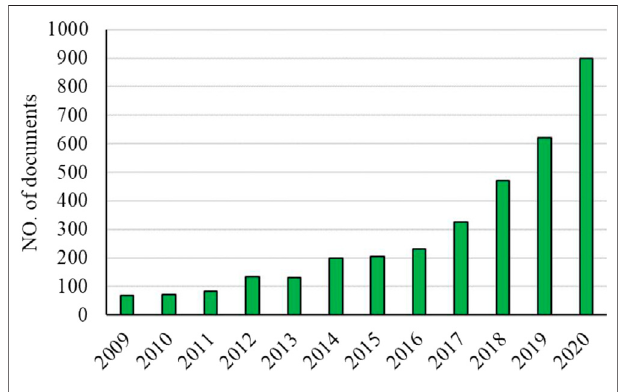
FIGURE 1 | Number of